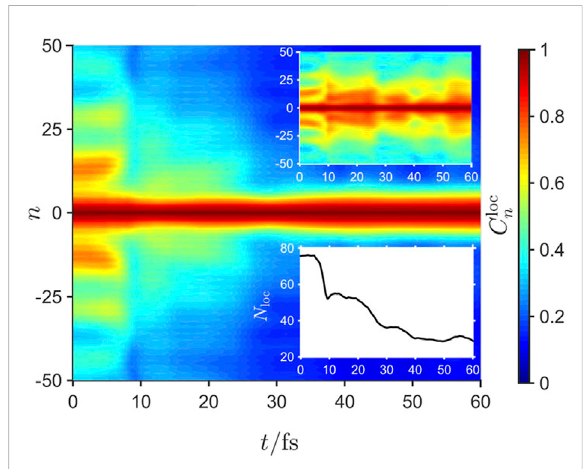
FIGURE 7 The time dependence of the exciton localization correlation function, C loc n (Eq. 28), for an initial high-energy QEES. The main fi gure corresponds to the time evolution with the dissipation time T = γ − 1 = 100 fs. The time dependence of the exciton density localization number, N loc (Eq. 29), is given in the lower inset. The upper inset corresponds to the time evolution without external dissipation showing that in this case exciton denisty localization does not occur. Reproduced from J. Chem. Phys. 148, 034901 (2018) with the permission of AIP